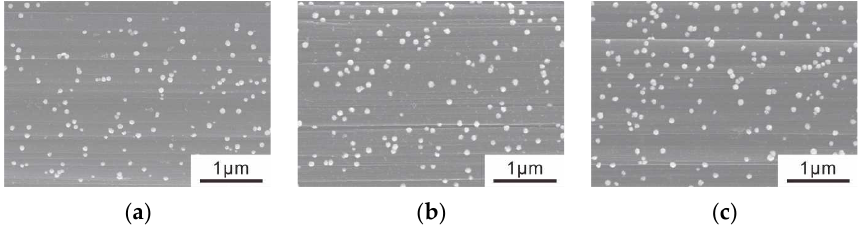
Figure 10. FE-SEM images of actual total plating time: ( a ) 5 s, ( b ) 10 s and ( c ) 15 s of P-Ni-CF ( I = 200 mA, J = 3.79 A/m 2 , t ON = 10 ms, t OFF = 100 ms, t = 5 s).